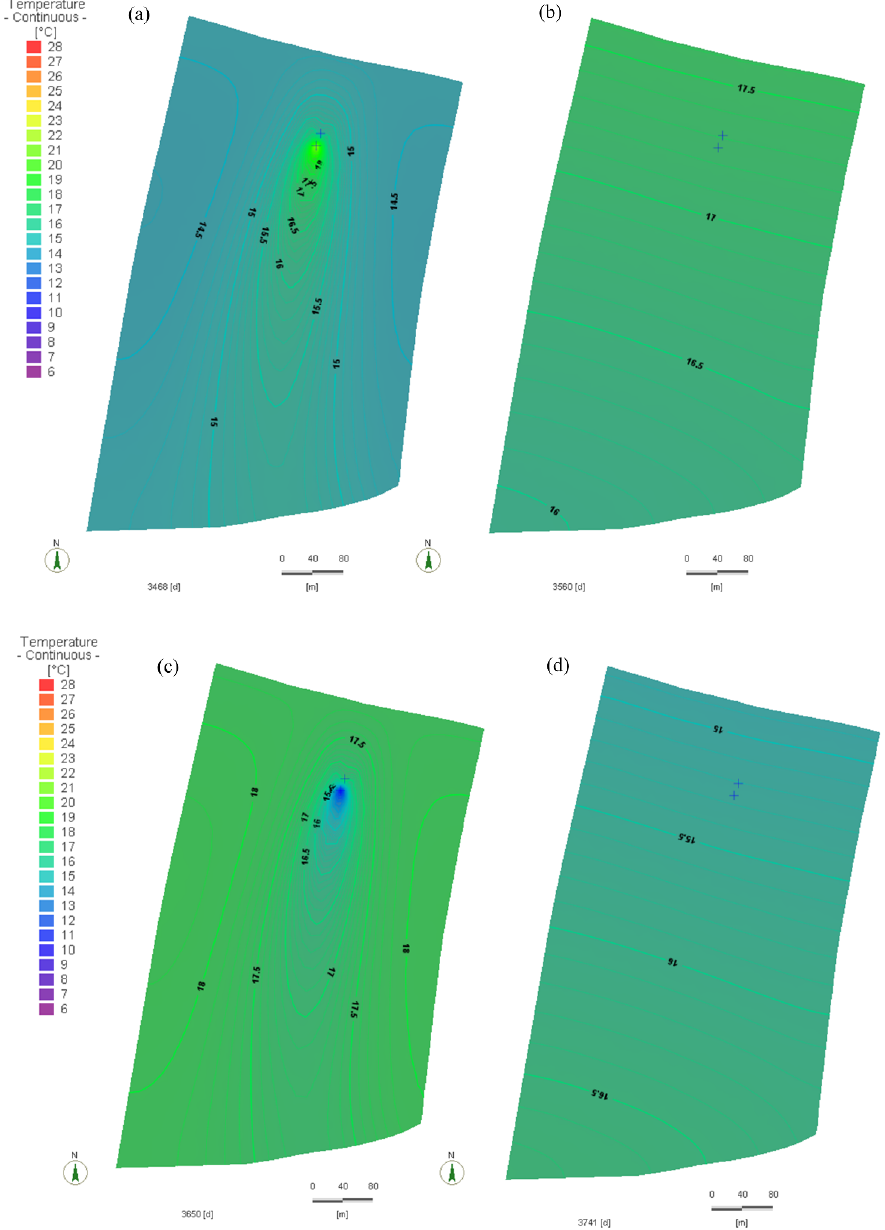
Figure 14. Thermal changes on variation VI (3.33 × 10 − 2 m 3 /s, 10 ◦ C) pumping rate 3.33 × 10 − 2 m 3 /s and injection temperature 10 ◦ C on local model 1, ( a ) during cooling operation, ( b ) after 90 days of cooling operation, ( c ) during heating operation, and ( d ) after 90 days of heating operation.